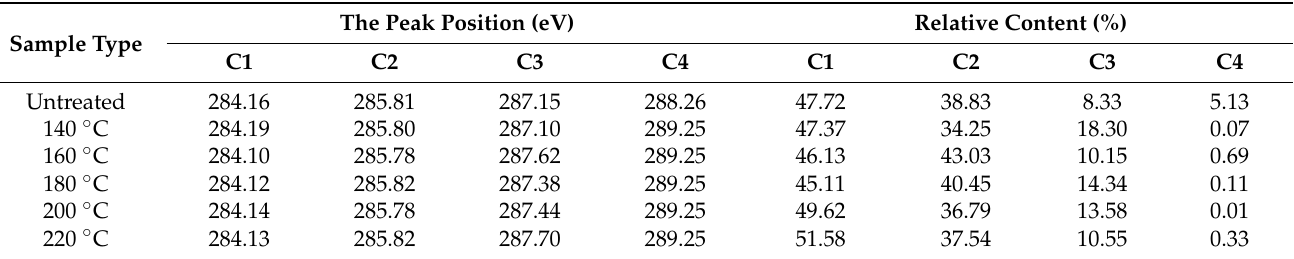
Table 4. Percentage of carbon in different chemical states of bamboo fiber before and after vacuum heat treatment.